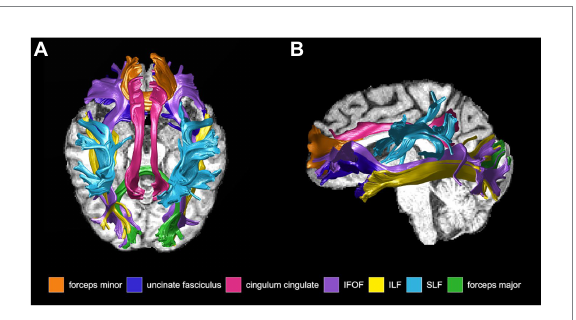
FIGURE 3 White matter tracts of interest obtained from Automated Fiber Quantification software and used for analysis, shown in (A) sagittal, and (B) axial view. IFOF, inferior fronto-occipital fasciculus; ILF, inferior longitudinal fasciculus; SLF, superior longitudinal